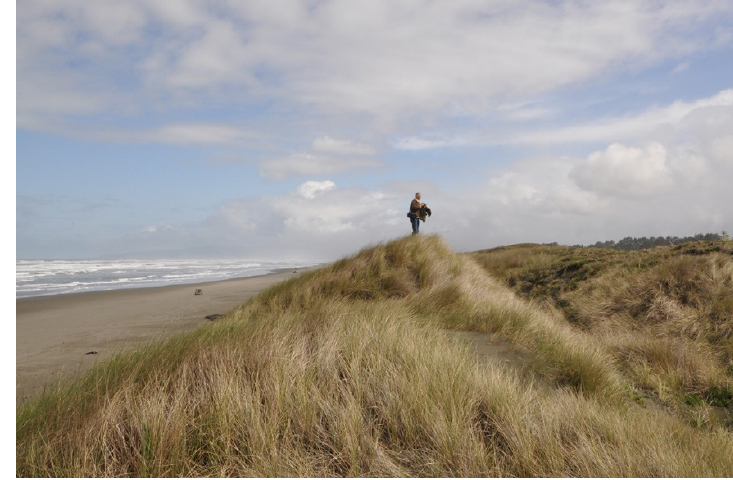
Figure 3. Steep peaked foredune characteristic of Ammophila.